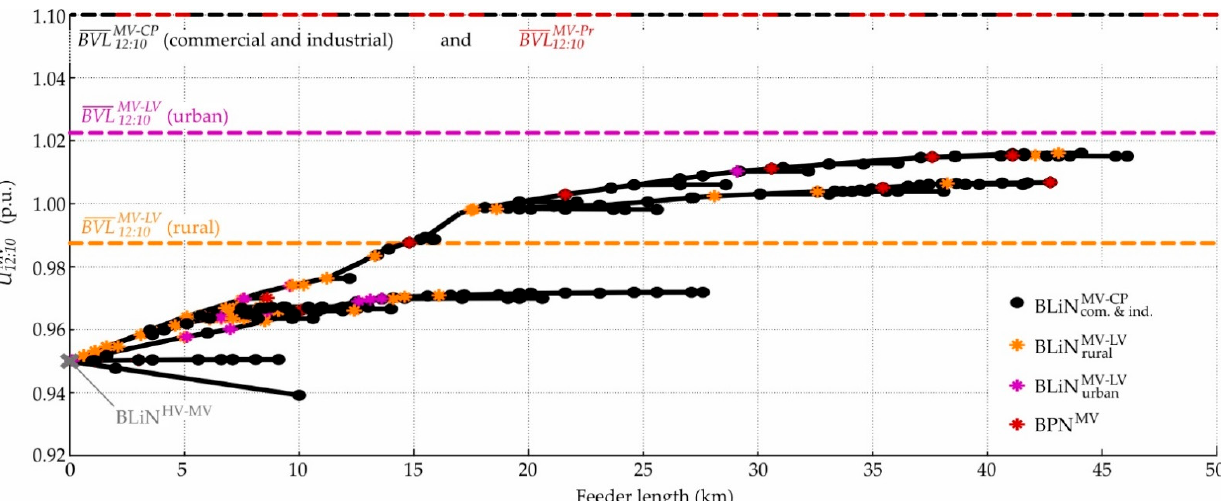
tion points of CP_Link-Grids and power plants. At 12:10 p.m., maximal voltages of 1.0225 and 0.9875 p.u. are acceptable at the BLiN MV-LV of the urban and rural LV_Link-Grid, re- spectively (see Figure 9 for the rural one). The voltages increase up to 1.0161 p.u., provok- ing upper limit violations for some BLiN MV-LV to the rural LV_Link-Grid. Consequently, case II lies within the upper limit violation zone. Figure 11 also shows that no LV_Link- Grids are connected to two relatively short MV feeders. This should be kept in mind when comparing the different Volt/var control strategies: in contrast with the PV inverter-based controls, the X ( U ) and OLTC local controls do not affect the voltage profiles of these two MV feeders. 3.1.2. Active Power Exchange Figure 12 shows the active power exchange over different system boundaries for var- ious boundary voltages and no Volt/var control. ( a ) ( b ) Figure 12. Daily active power exchange over different system boundaries for various boundary voltages and no Volt/var control: ( a ) MV − LV boundary (rural LV_Link-Grid); ( b ) HV − MV boundary. The daytime and the corresponding boundary voltage are plotted on the abscissa and ordinate, respectively. Meanwhile, the active power exchange is presented in the relevant zone, i.e., between the upper and lower BVL s, using different color shades from red for